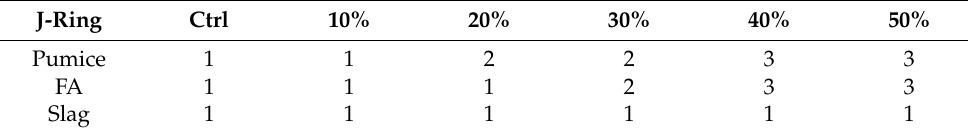
Table 4. J-ring test value for each binary samples.